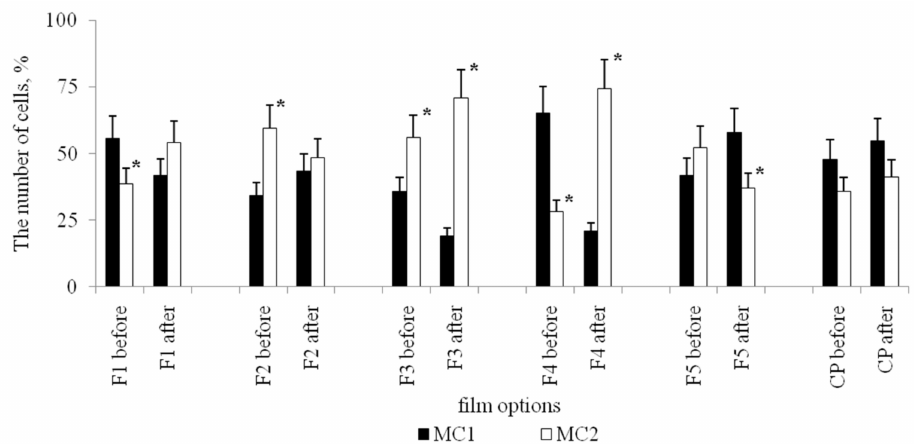
Figure 7. The number of rounded (MC1) and elongated (MC2) cells in the MPh population on PHA-films before and after stenting. CP—cultural plastic. F1–F5—PHA-films. * —The values for the variant